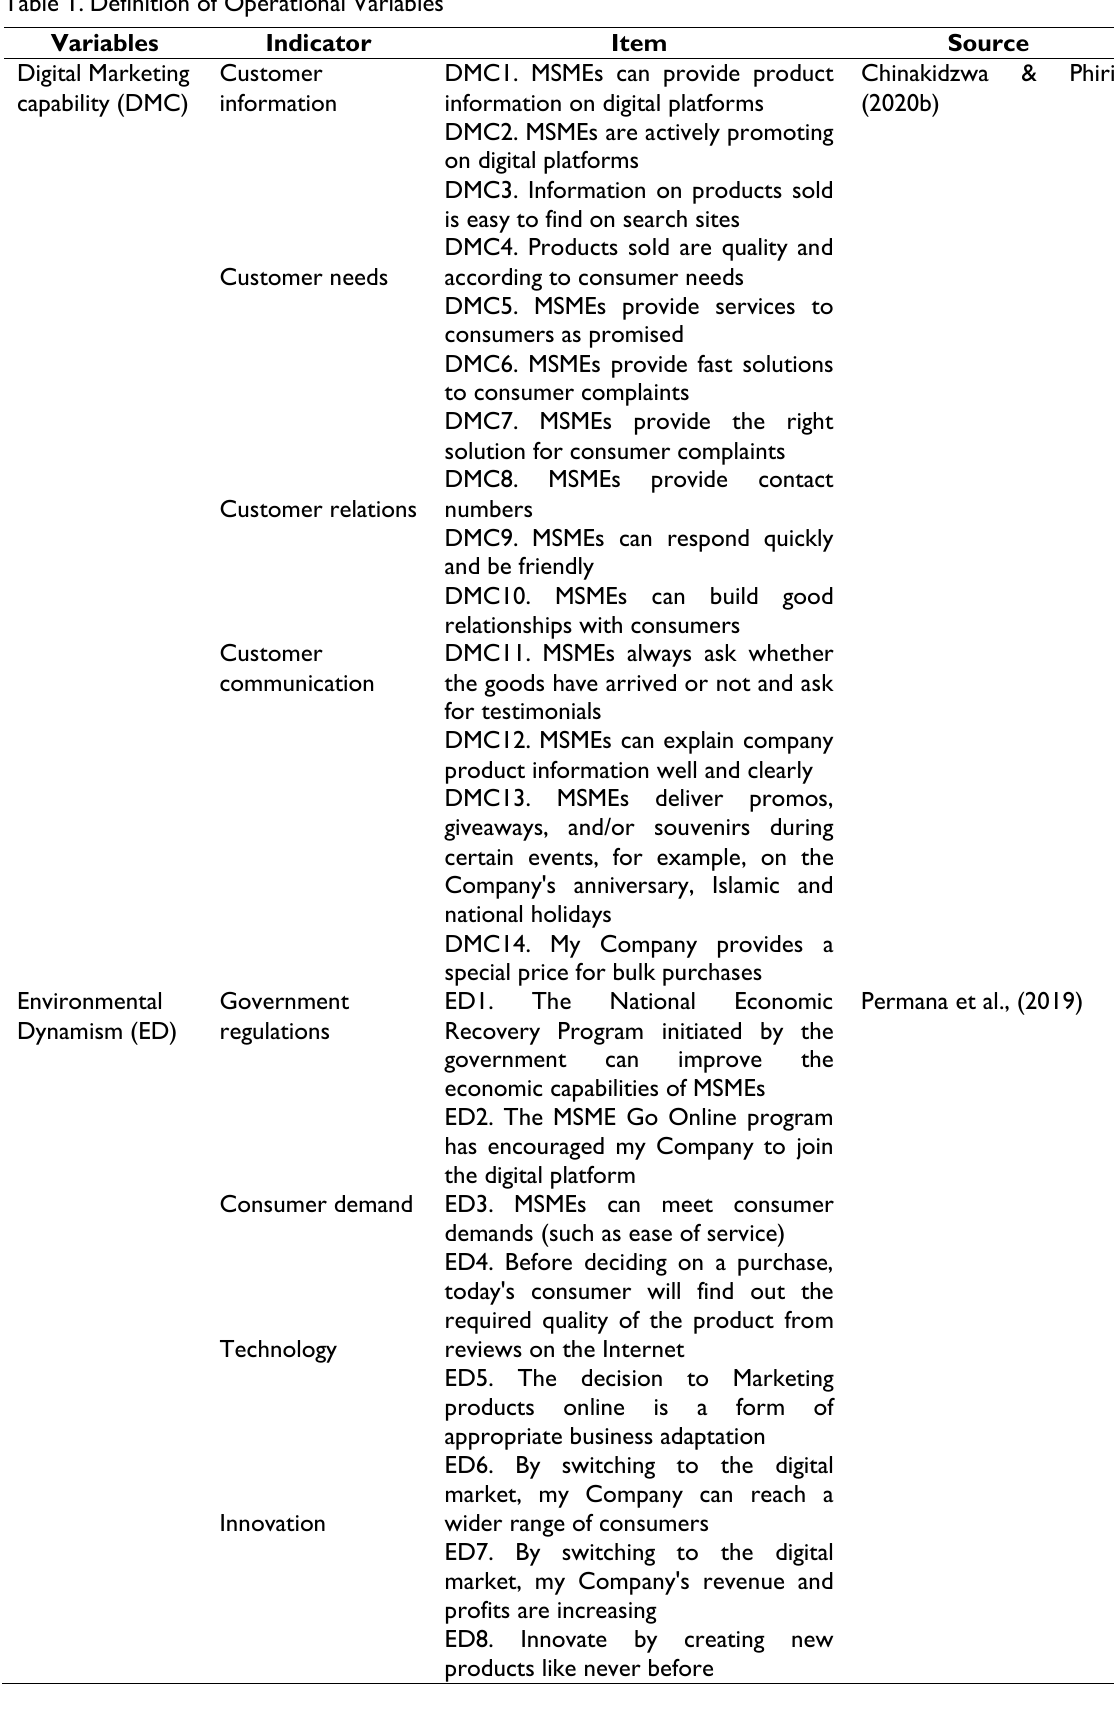
Table 1. Definition of Operational Variables Variables Indicator Item